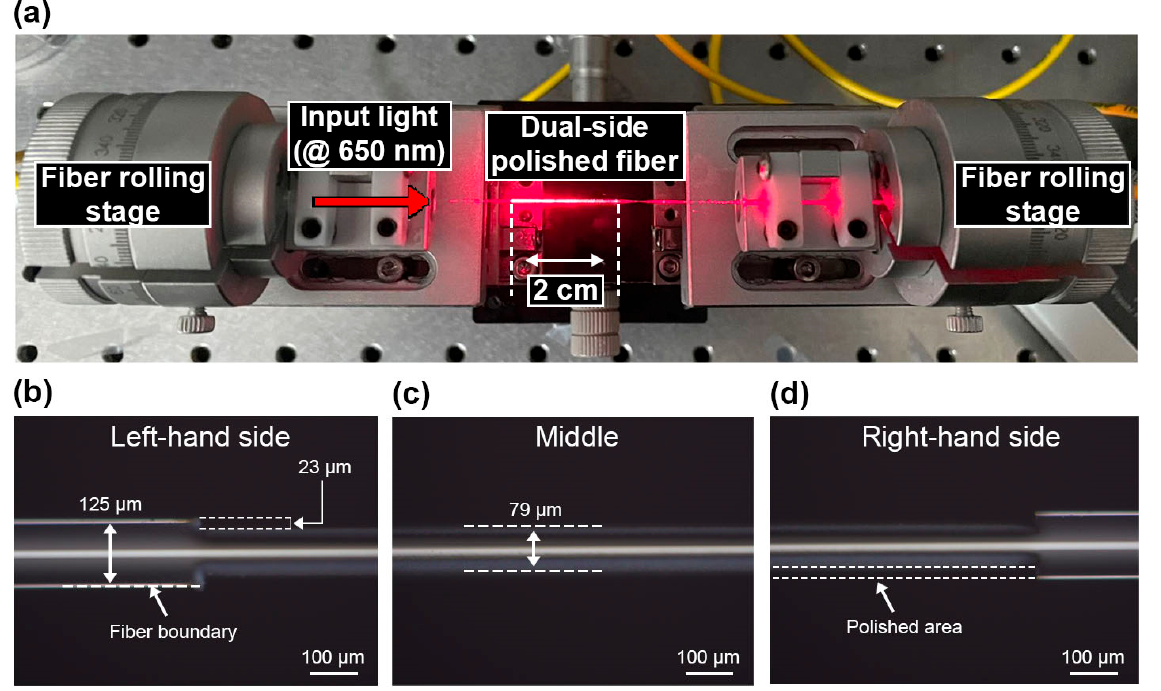
Figure 6. ( a ) Fabricated dual-side polished fiber fixed on two fiber rolling stages. Optical microscope images of the ( b ) left-hand, ( c ) middle, and ( d ) right-hand sides of the dual-side polished fiber under 10× magnification.